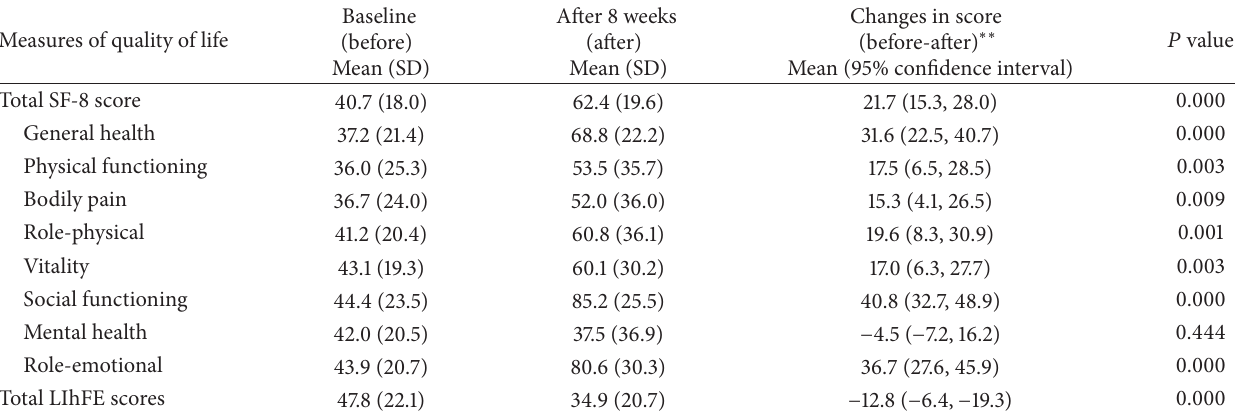
Table 4: The changes in the quality of life among 50 adult patients after two months of telecardiology consultations as measured by SF-8 and its domains and LIhFE ∗